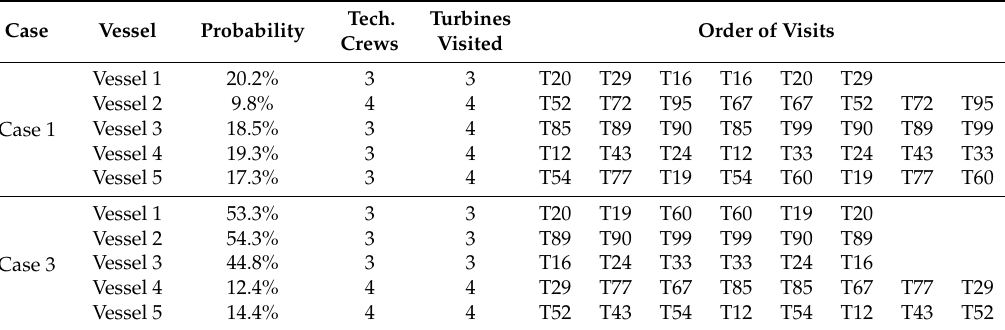
Table 2. Suggested order of visits for cases 1 and